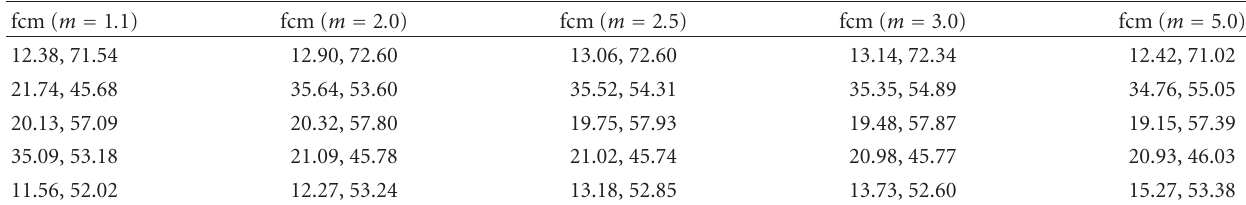
Table 8: Cluster centers (X, Y) for various values of fuzziness parameter: m = 1 . 1,2 . 0,2 . 5,3 . 0,5 .